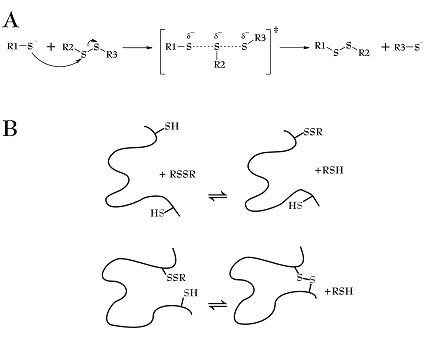
A. Thiol-disulfide exchange mechanism: in the pH range above 8, cysteine thiols are readily converted to thiolate anions (RS-), which are potent nucleophiles. RS- anions attack a disulfide bond, displacing one sulfur atom and forming a new bond with the other sulfur atom (nucleophilic substitution). The rate-determining step of this concerted process is the formation of a transition state with a partial transfer of the negative charge (δ-) over the three sulfur atoms. B. The formation of a disulfide bond on the polypeptide chain (solid curve) with the help of a small molecule reagent (thiol form: RSH, disulfide form: RSSR). The two steps both proceed via a thiol-disulfide exchange reaction. The first step shown is intermolecular and the second intramolecular. The rate of the intramolecular step is relevant to protein folding, since it also involves conformational changes.